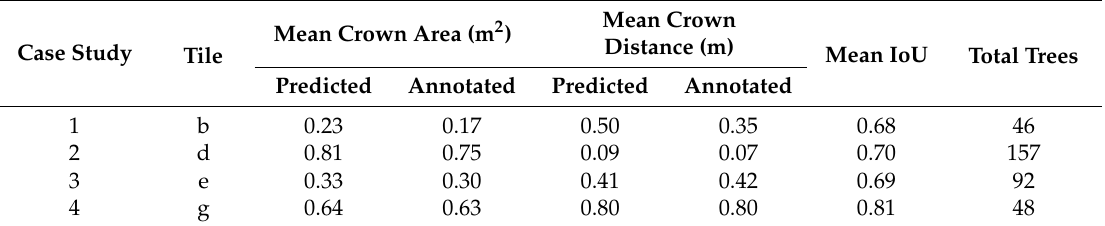
Table 6. Descriptive metrics for the external validation tiles discussed in Case Study